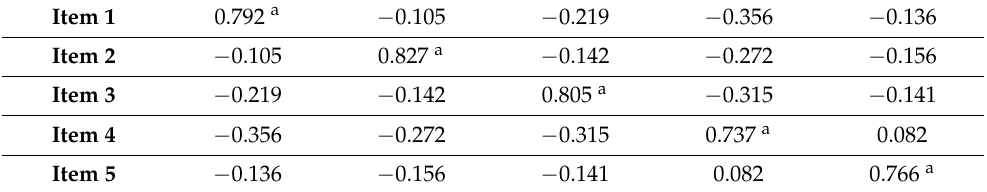
Table 4. Anti-image matrix with sampling adequacy measure ( a Sampling adequacy